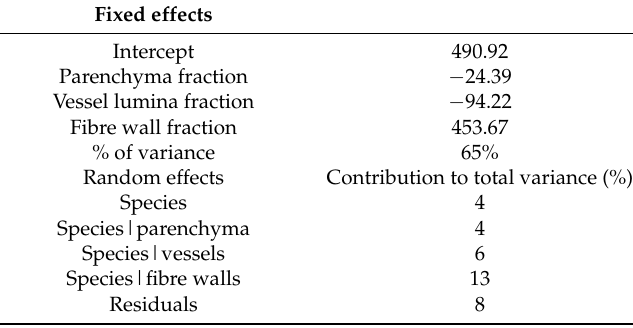
Table 3. Coefficients from a Gaussian linear mixed model (random intercept + slope) predicting wood density from the anatomical variables for 8 tropical species investigated. Coefficient estimates are provided for the fixed effects (at 95% of confidence